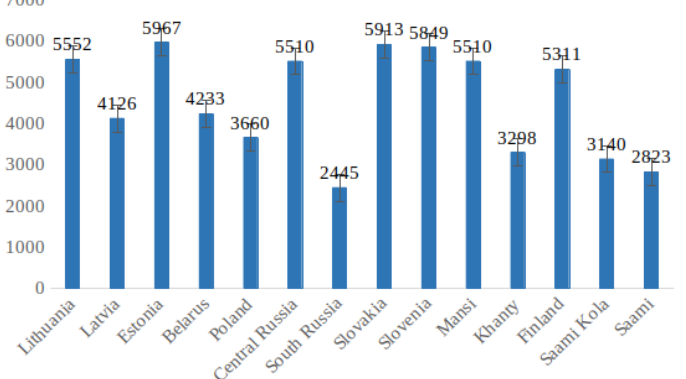
Figure 4. The harmonic mean of estimated Ne for each population. Error bars indicate 95% confidence intervals on each estimate.